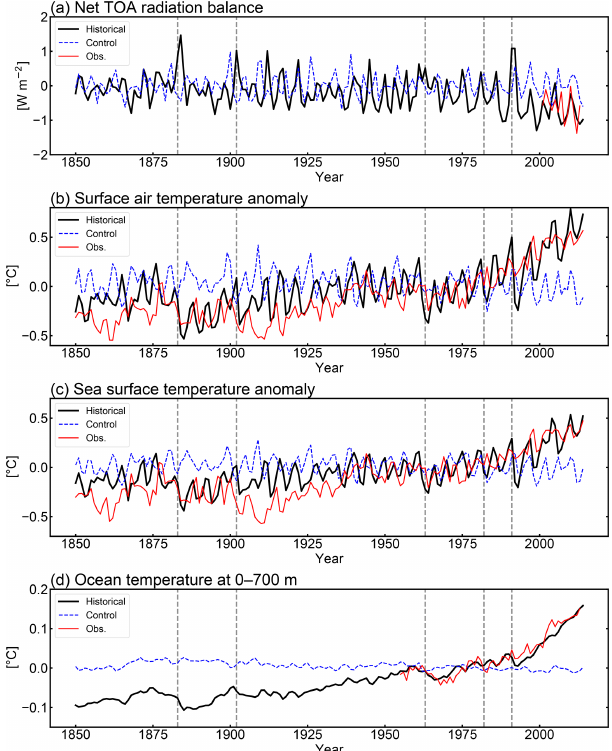
Figure 2. Comparison of HIST simulation results by MIROC-ES2L with observations: anomalies of (a) net radiation balance at the top of the atmosphere (TOA; upward positive), (b) global mean sur- face air temperature, (c) global mean sea surface temperature, and (d) global mean ocean temperature at 0–700m of depth. Black, red, and blue lines represent historical simulations, historical observa- tions, and pi-control simulations, respectively. Vertical dashed lines represent the timing of major volcanic eruptions (i.e., Krakatau in 1883, Santa Maria in 1902, Agung in 1963, El Chichón in 1982, and Pinatubo in 1991). In panel (a) , the simulation results are pre- sented as anomalies from the 1850–2014 average of the CTL run. In panels (b) , (c) , and (d) , the results are presented as the anomalies from the 1961–1990 averages. Observation data for the radiation balance were obtained from the global product of CERES EBAF- TOA edition 4.0. Observation data for SAT and SST were obtained from HadCRUT4 (Morice et al., 2012) version 4.6 and HadSST (Kennedy et al., 2011) version 3.1.1, respectively. The ocean tem- perature anomaly updated from Levitus et al. (2012) is used to com- pare ocean temperature at 0–700m of depth during the period 1955–